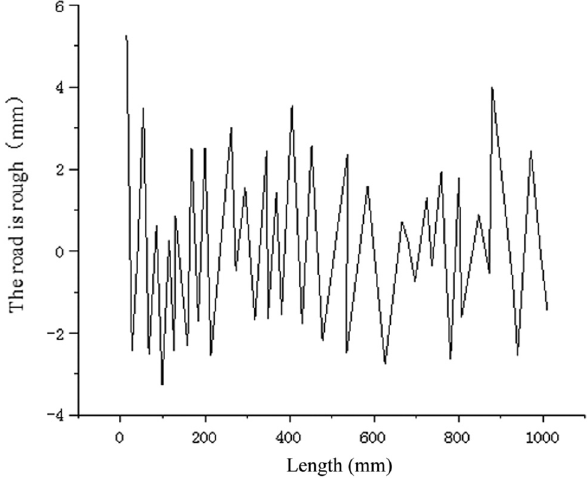
Figure 3: Results of A - grade pavement roughness simulated by AR model.